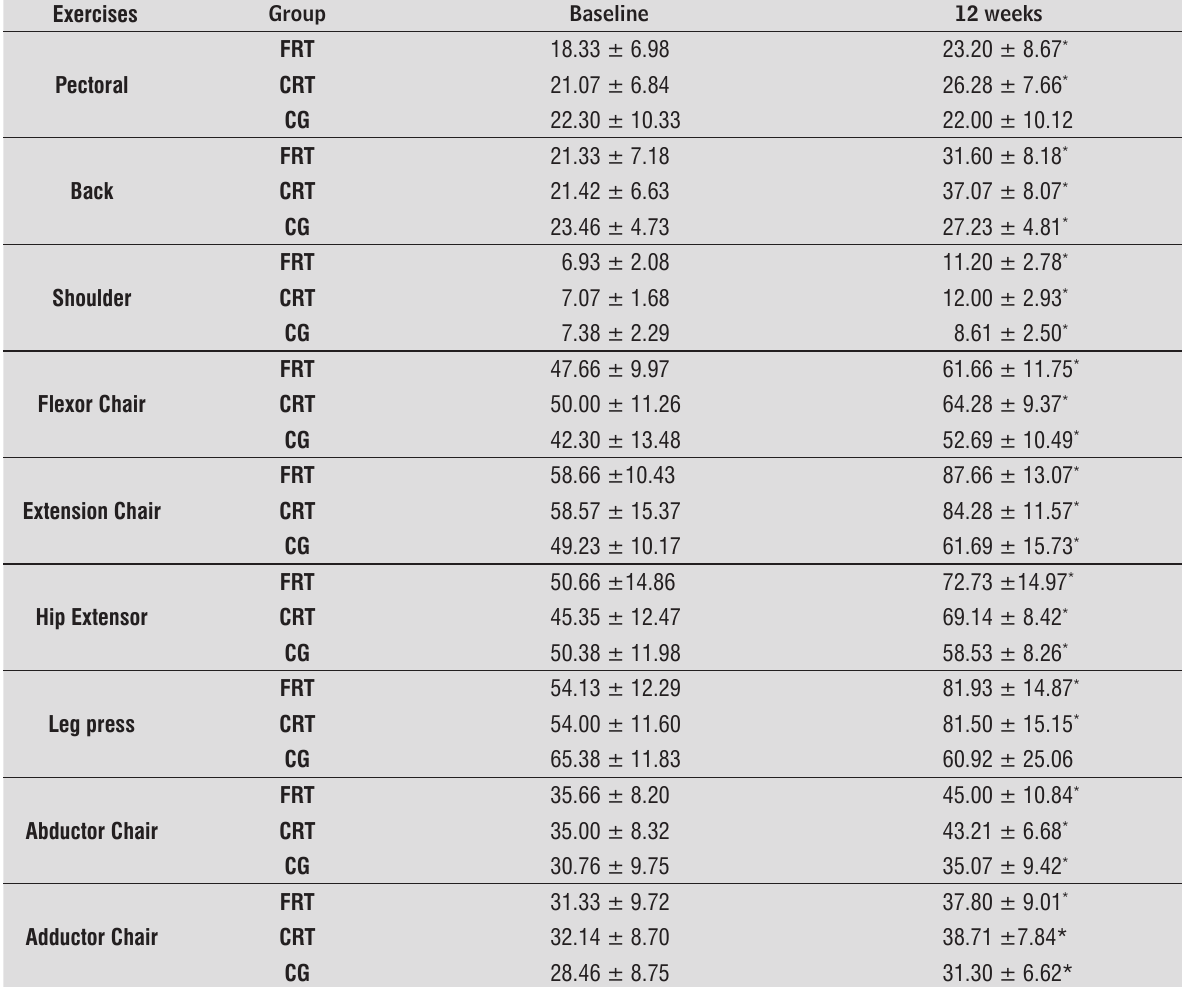
Table 2 - Mean and standard deviation of the values in kilograms of the 1RM test for upper and lower limbs